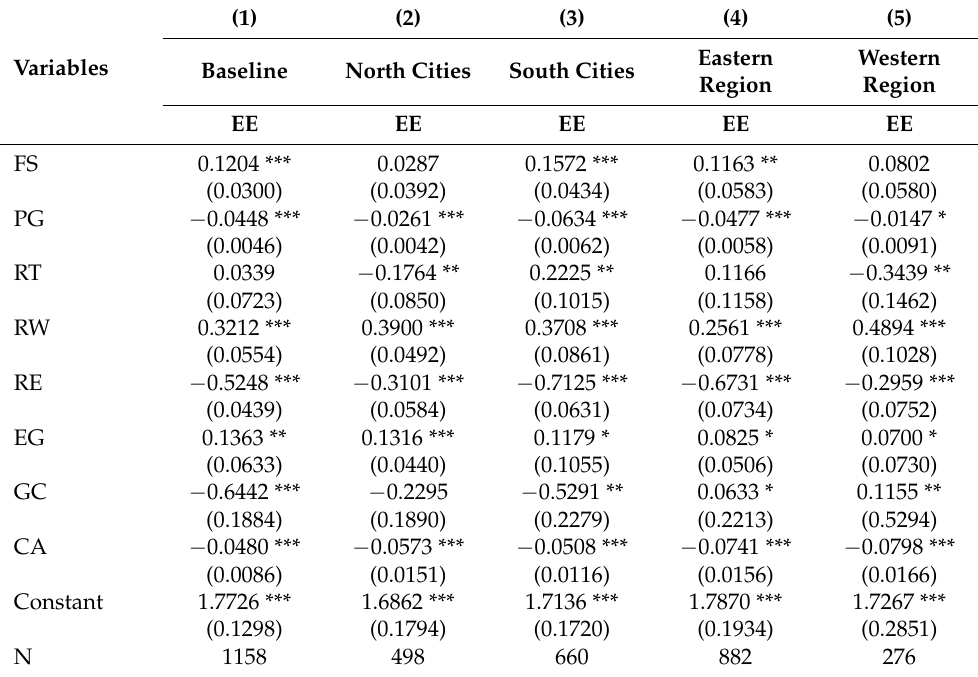
Table 6. Empirical analysis of spatial location heterogeneity